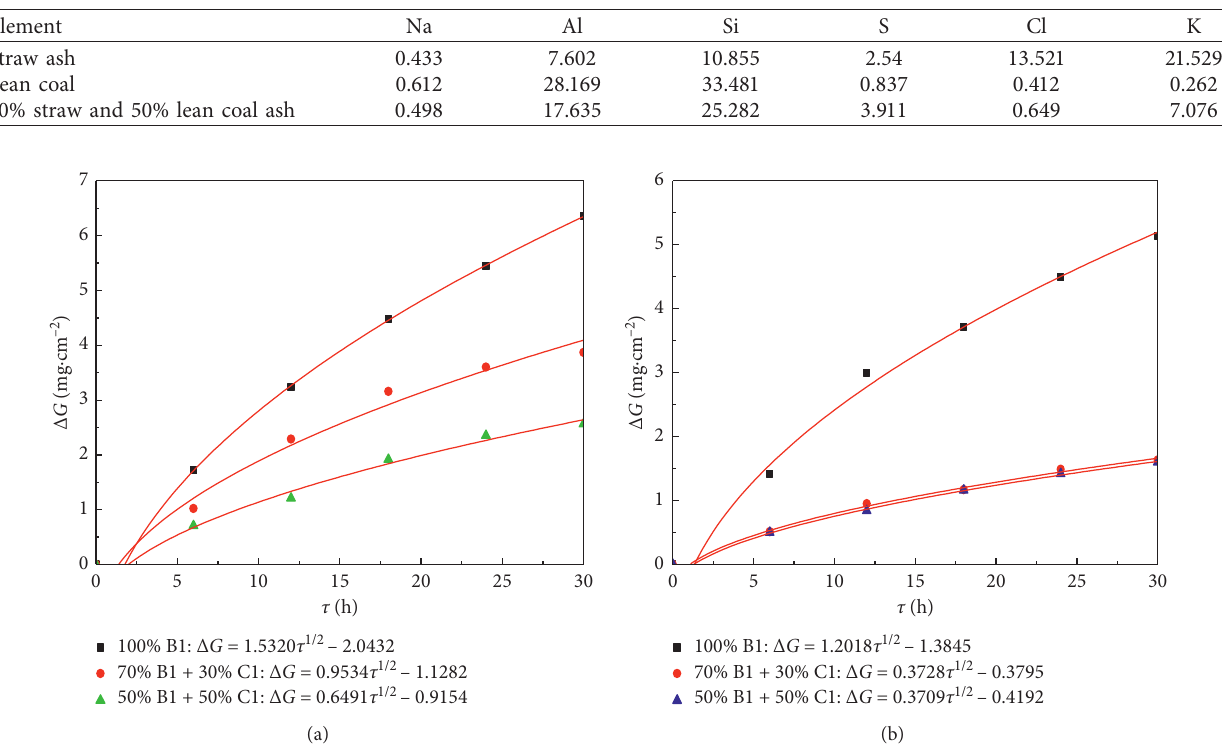
Figure 8: Curves and fitting correlations of corrosion weight gain of the metal samples coated with ash under different atmospheres. (a) HCl :500 μ L/L, not containing SO 2 . (b) SO 2 : 500 μ L/L, not containing